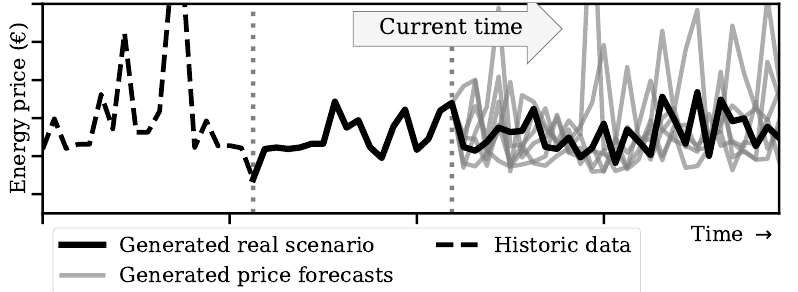
Figure 2. The auto-regressive moving average model with exogenous variables (ARMAX) is used to generate a real scenario (for evaluation) from historic data. ARMAX is then used to generate a number of price forecasts from the scenario. These price forecasts are updated at every time step, starting from the current time (second vertical line in the